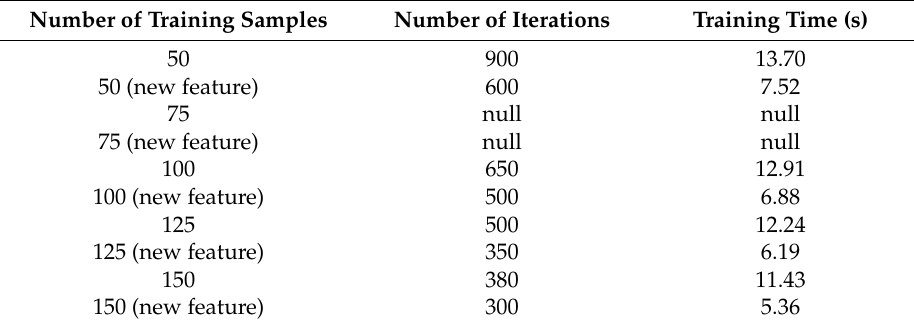
Table 14. Comparison of model training results with different number of training